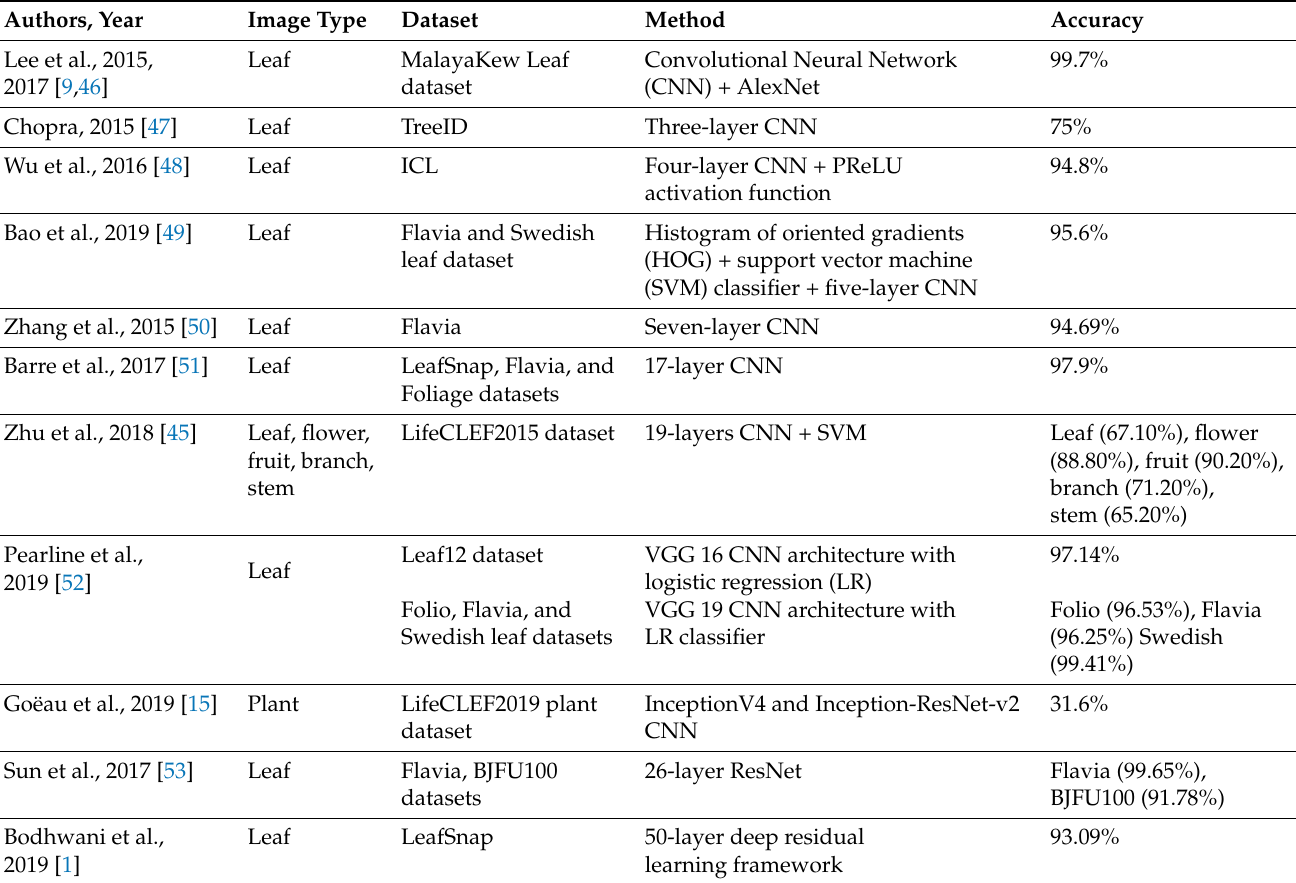
Table 1. Summary of related works in deep